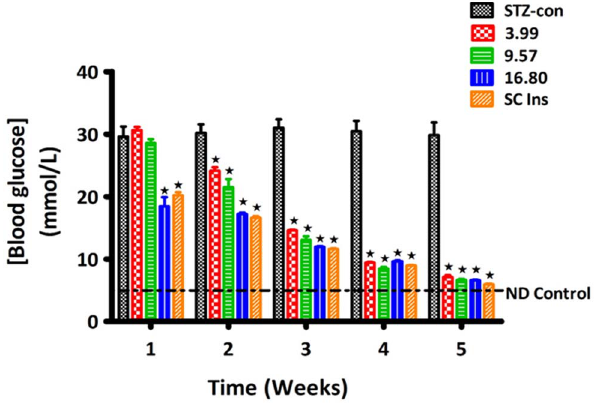
Figure 5. Comparison of the effects on blood glucose of STZ- induced diabetic rats treated with transdermal PI hydrogel matrix patches on the skin and diabetic rats treated with sc insulin with untreated animals. Animals treated with drug-free pectin and subcutaneous insulin (175 m g/kg) acted as negative and positive controls, respectively. Values are presented as means, and vertical bars indicate SEM of means (n=6 in each group). w p , 0.05 by comparison with control